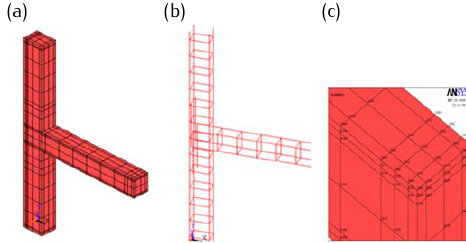
Figure 10. ANSYS finite element model with reinforcement and node numbers.